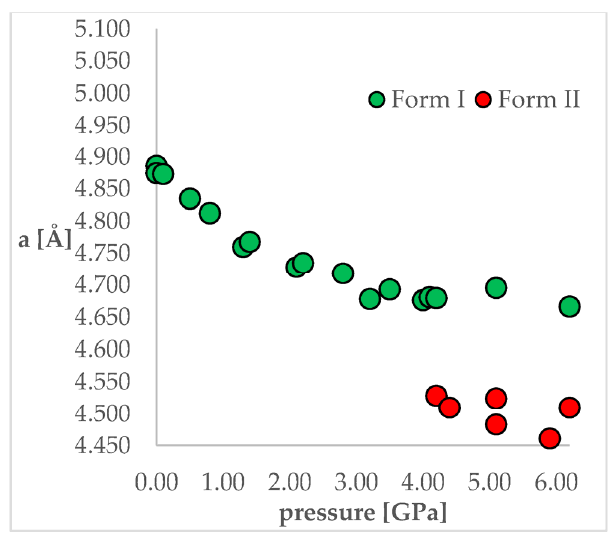
Figure 2. The change of unit cell edge “a” length with respect to pressure. Green circles—Form I, Red circles—Form II. Table 1. Structural parameters of crystal forms of chlorothiazide. Data for Form II were bolded to increase the clarity.